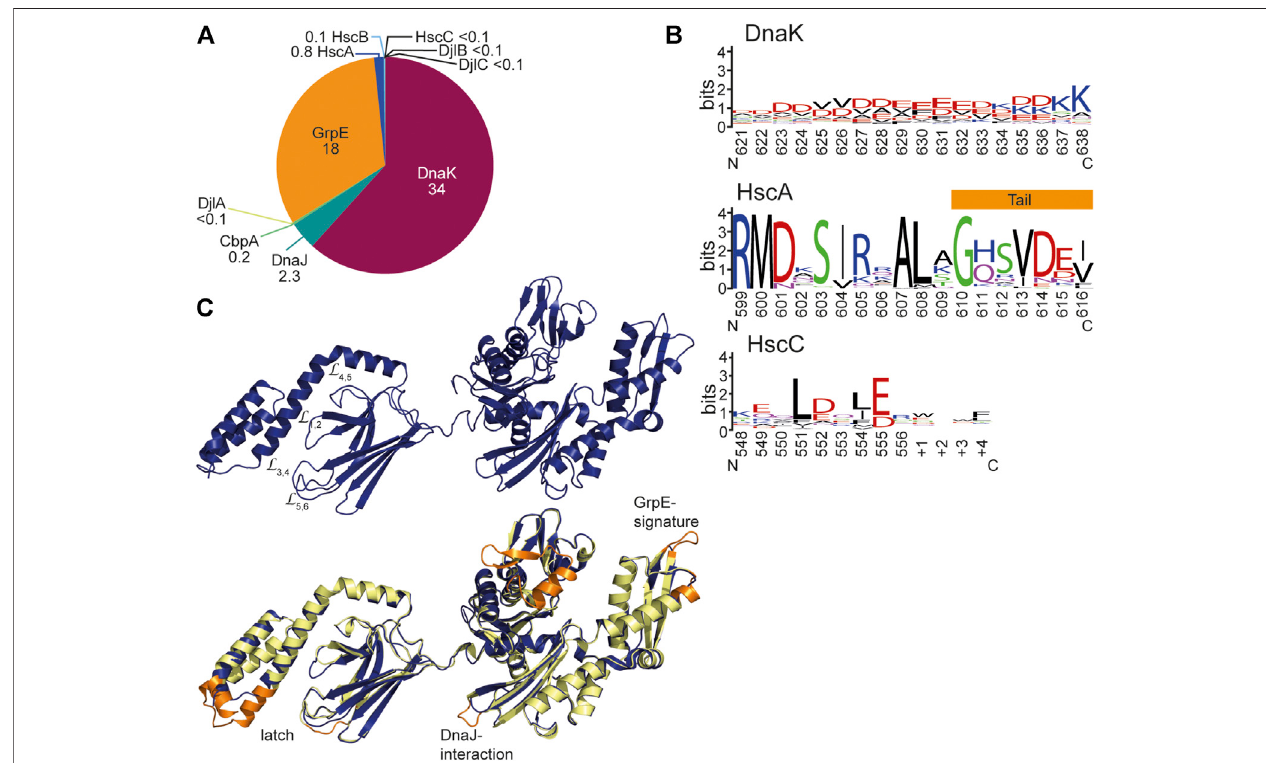
FIGURE 8 | Structural differences between DnaK and HscA and HscC. (A) , Concentrations of the components of the Hsp70 systems in wild type E. coli in non- stress conditions and exponential growth phase. Numbers indicate concentrations in µM according to (Fauvet et al., 2021). < 0.1 indicates that these components were below the detection limit of this quantitative mass spectrometry experiment. (B) , Weblogo of the C-terminal residues of DnaK, HscA and HscC. DnaK Weblogo, E. coli DnaK was used in a BLAST search against the UniRef90 database of clusters of mutually more than 90% identical sequences, and the C-terminal 18 residues of these representative sequences were used to generate the WebLogo since the C-terminal tail sequences do not align well in multiple sequence alignments due to low complexity (https://weblogo.berkeley.edu/logo.cgi) (Crooks et al., 2004). HscA Weblogo, 194 representative HscA sequences of the UniRef90 database were aligned usingCLUSTAL Ω .The18residuesthatcorrespondtotheunstructuredtailinDnaKwereusedtogeneratetheWebLogo.FromthecrystalstructureofHscA-SBDhelixE is longer in HscA than in DnaK and only the last 7 residues are unstructured. HscC WebLogo, 191 representative HscC sequences from the UniRef90 database were alignedusingCLUSTAL Ω .The13residues(9for E.coli HscC)thatcorrespondtotheC-terminaltailofDnaKwereusedtogeneratetheWebLogo. (C) ,Homologymodel of E.coli HscCgeneratedusingiTASSER(Yangetal.,2015b;YangandZhang,2015).Lowerpanel,overlayofthehomology modelofHscC(darkblue)ontothesolution conformation of E. coli DnaK (2KHO, (Bertelsen et al., 2009), shown in light yellow and orange. Orange are the sequence regions that are deleted in